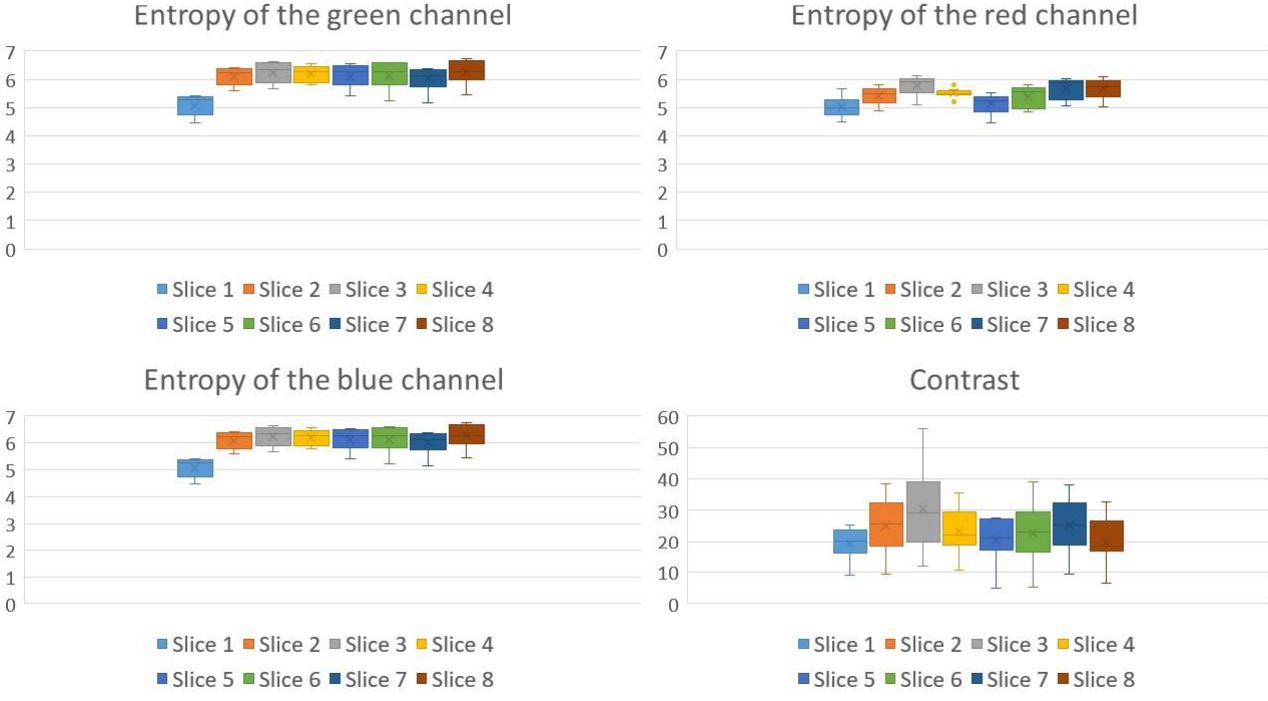
Figure 11. Variation of visual features of apple slices during the dehydration process: entropy of the green, red and blue channels; contrast.